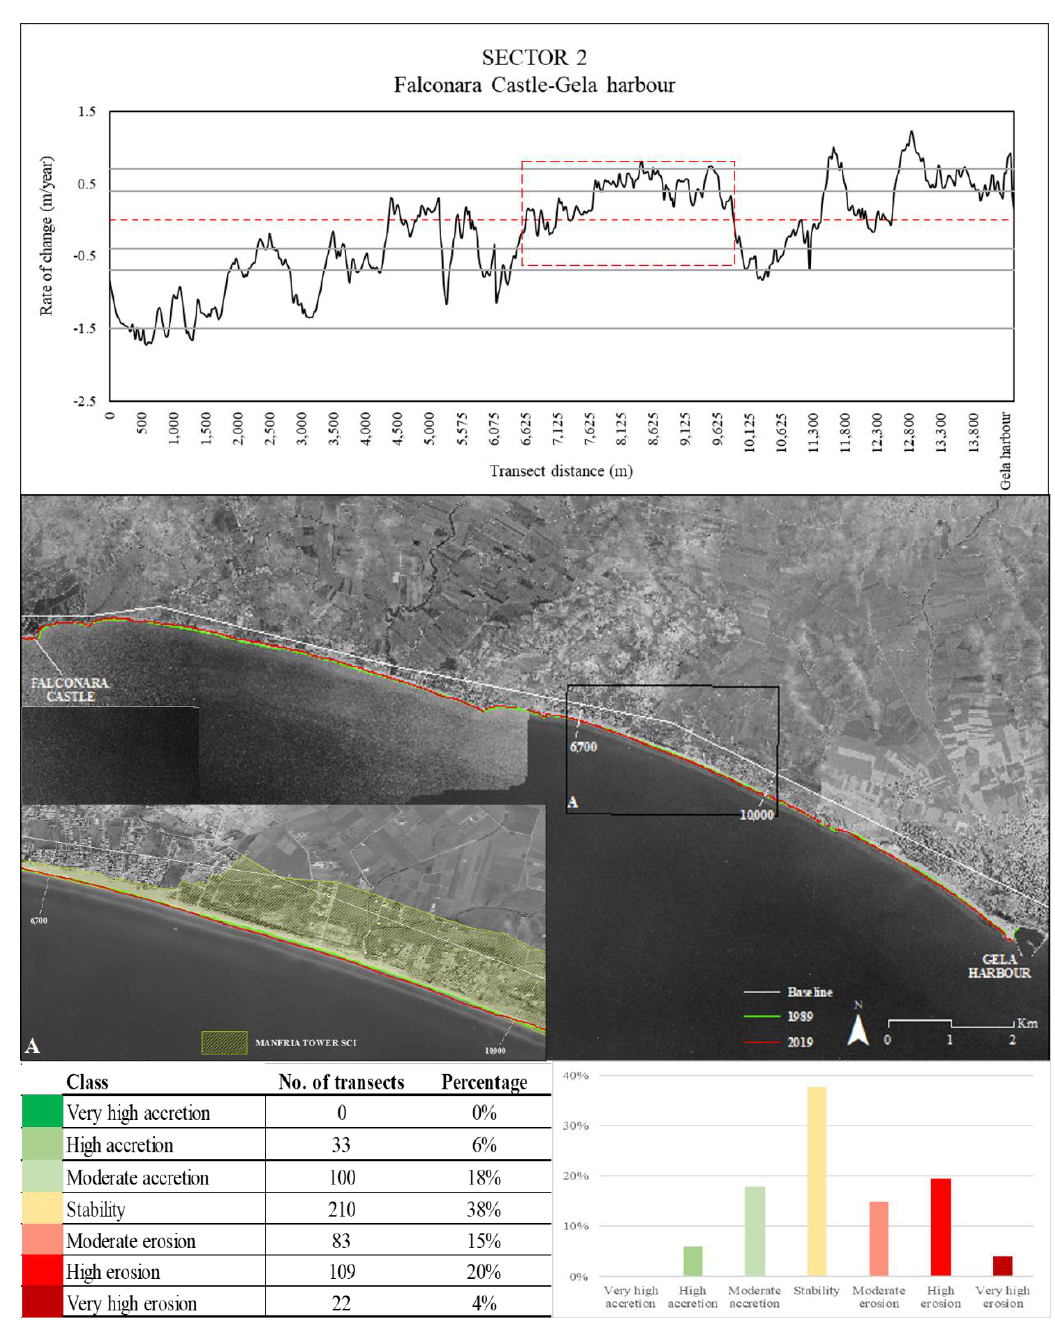
the intense sediment loss.. Grey dashed lines are those transects cast by the DSAS and delimit coastal areas that have recorded main changes.